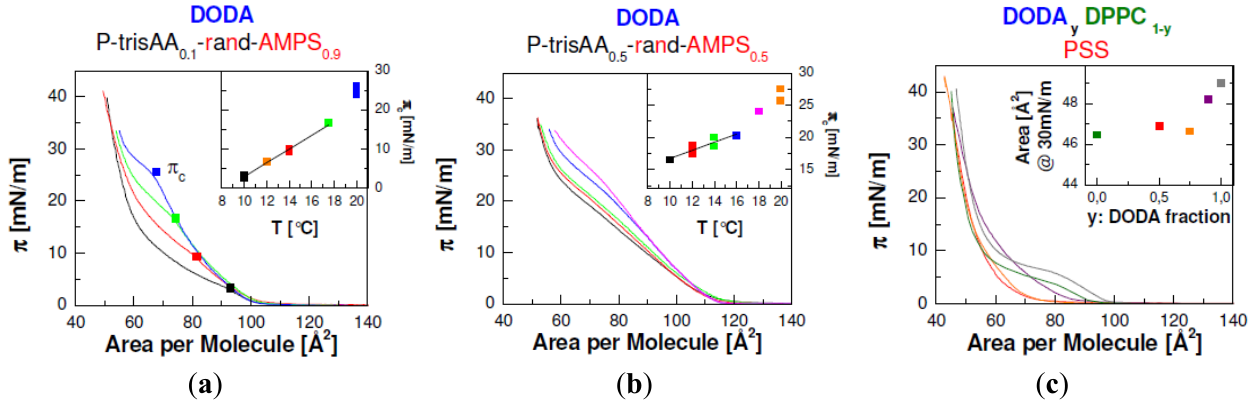
Figure 1. Surface pressure—area isotherms of lipid monolayers on 0.01 mmol/L PE solution (with respect to the monomer concentration). ( a , b ): dioctadecyldimethylammonium (DODA) isotherms with the statistical copolymer P–TrisAA temperatures indicated. (( a ) x = 0.9; ( b ) x = 0.5). The surface pressure π the LE/LC phase transition. The temperature dependence of π ( c ) π –A isotherms of DODA/DPPC mixtures at 20 °C with PSS ( M